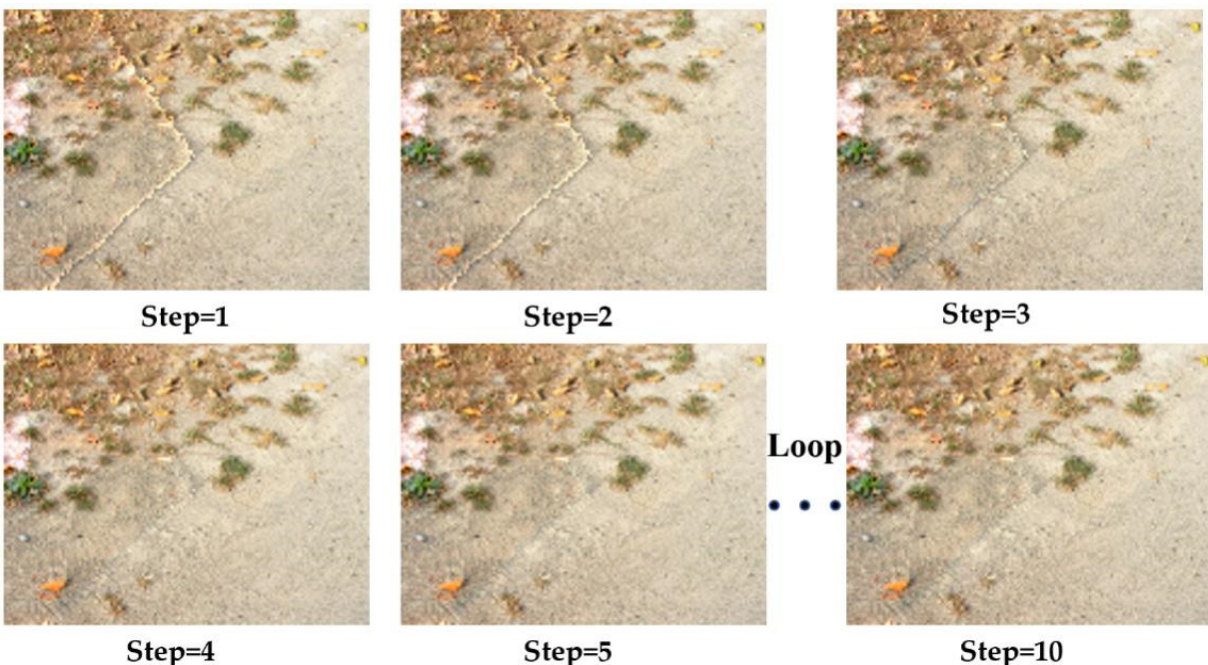
Figure 8. Process of dynamic penumbra compensation. From Steps 1 to 10, the ratio r was calculated separately and the penumbra was compensated step by step.